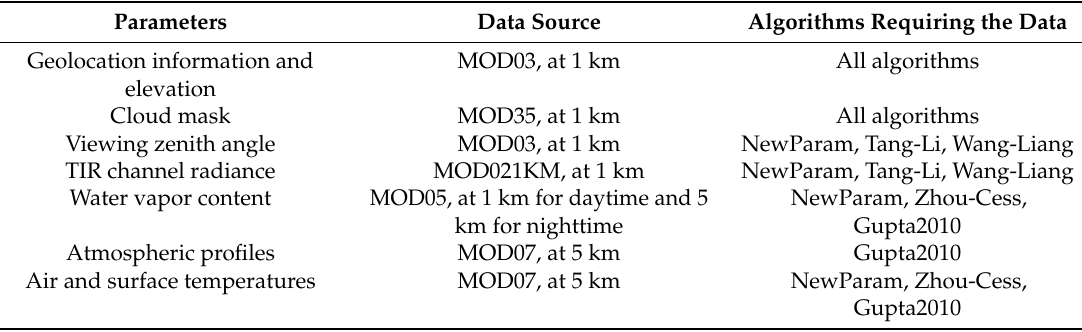
Table 5. Input parameters and data sources used in this